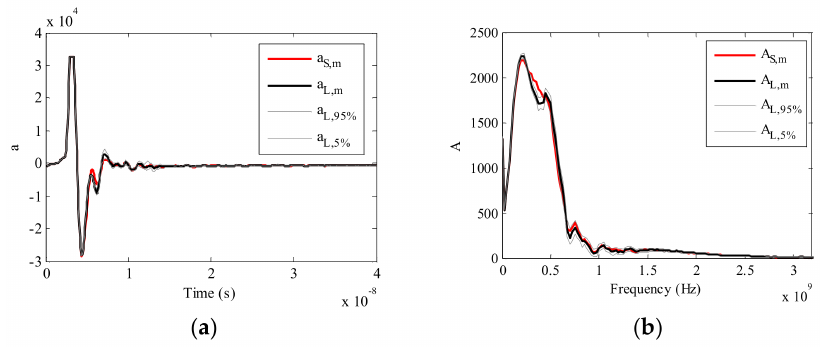
Figure 3. Example of the amplitude of the GPR signal in time domain ( a ) and in the frequency domain ( b